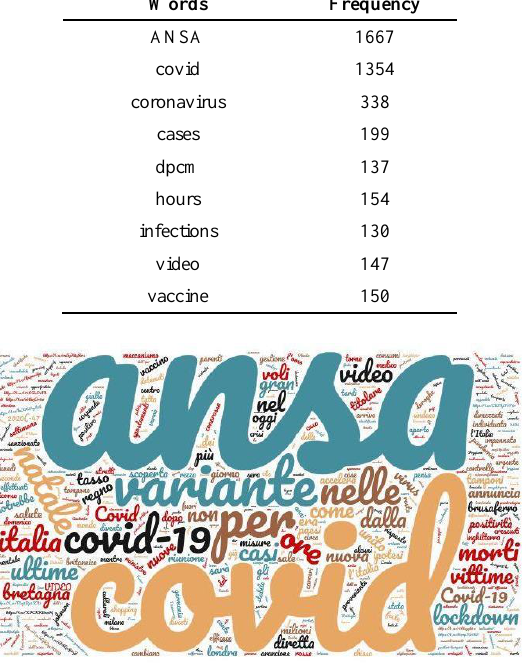
Figure 5. Word Cloud of the most frequent words for negative spikes.